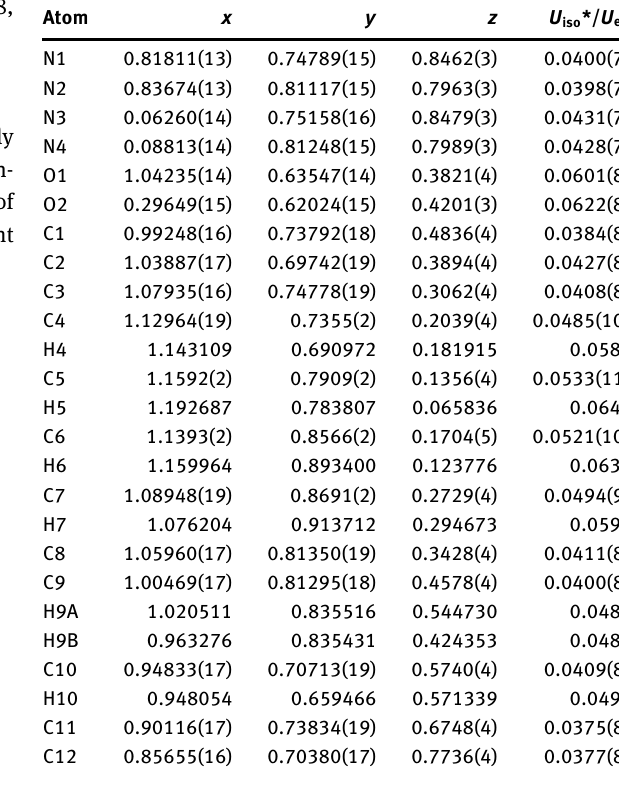
Table 2: Fractional atomic coordinates and isotropic or